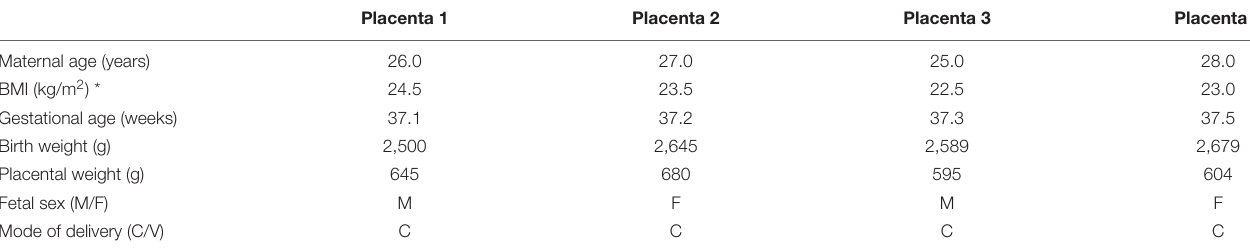
TABLE 1 | Selected clinical data of the mothers and newborns from whom placental samples were obtained for the transcriptomics analysis. Placenta